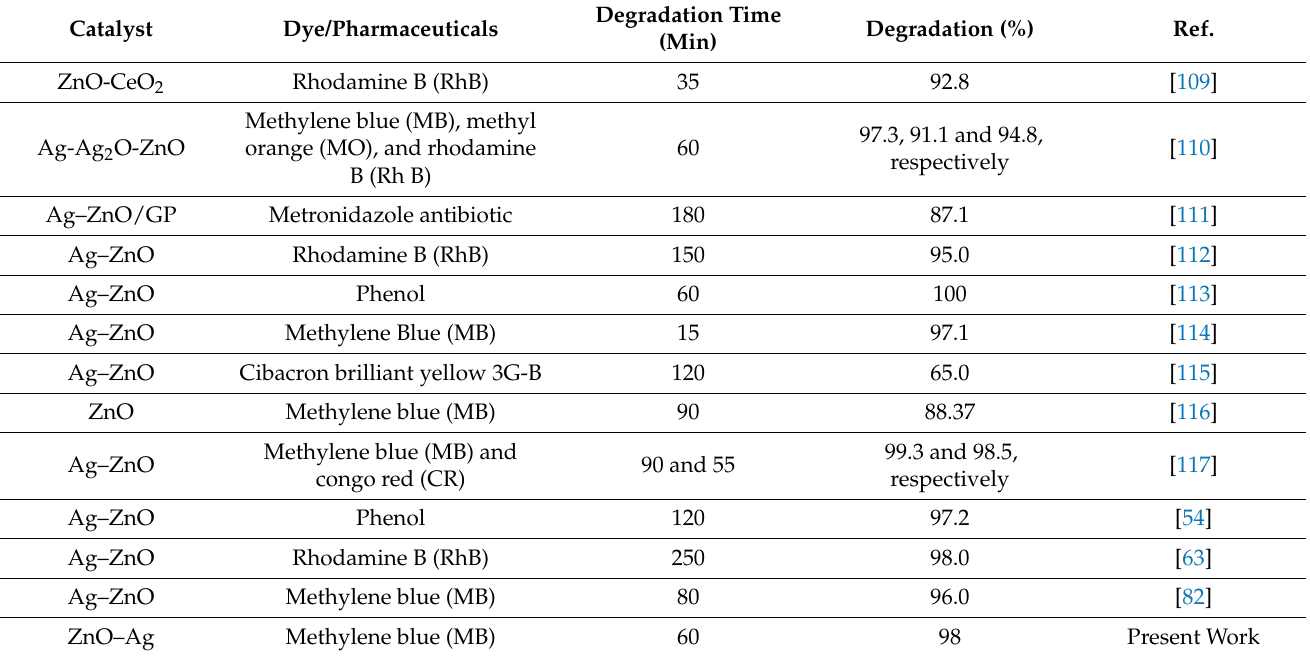
Table 3. Literature survey concerned with ZnO–Ag nanocomposite in photodegradation of organic dyes and